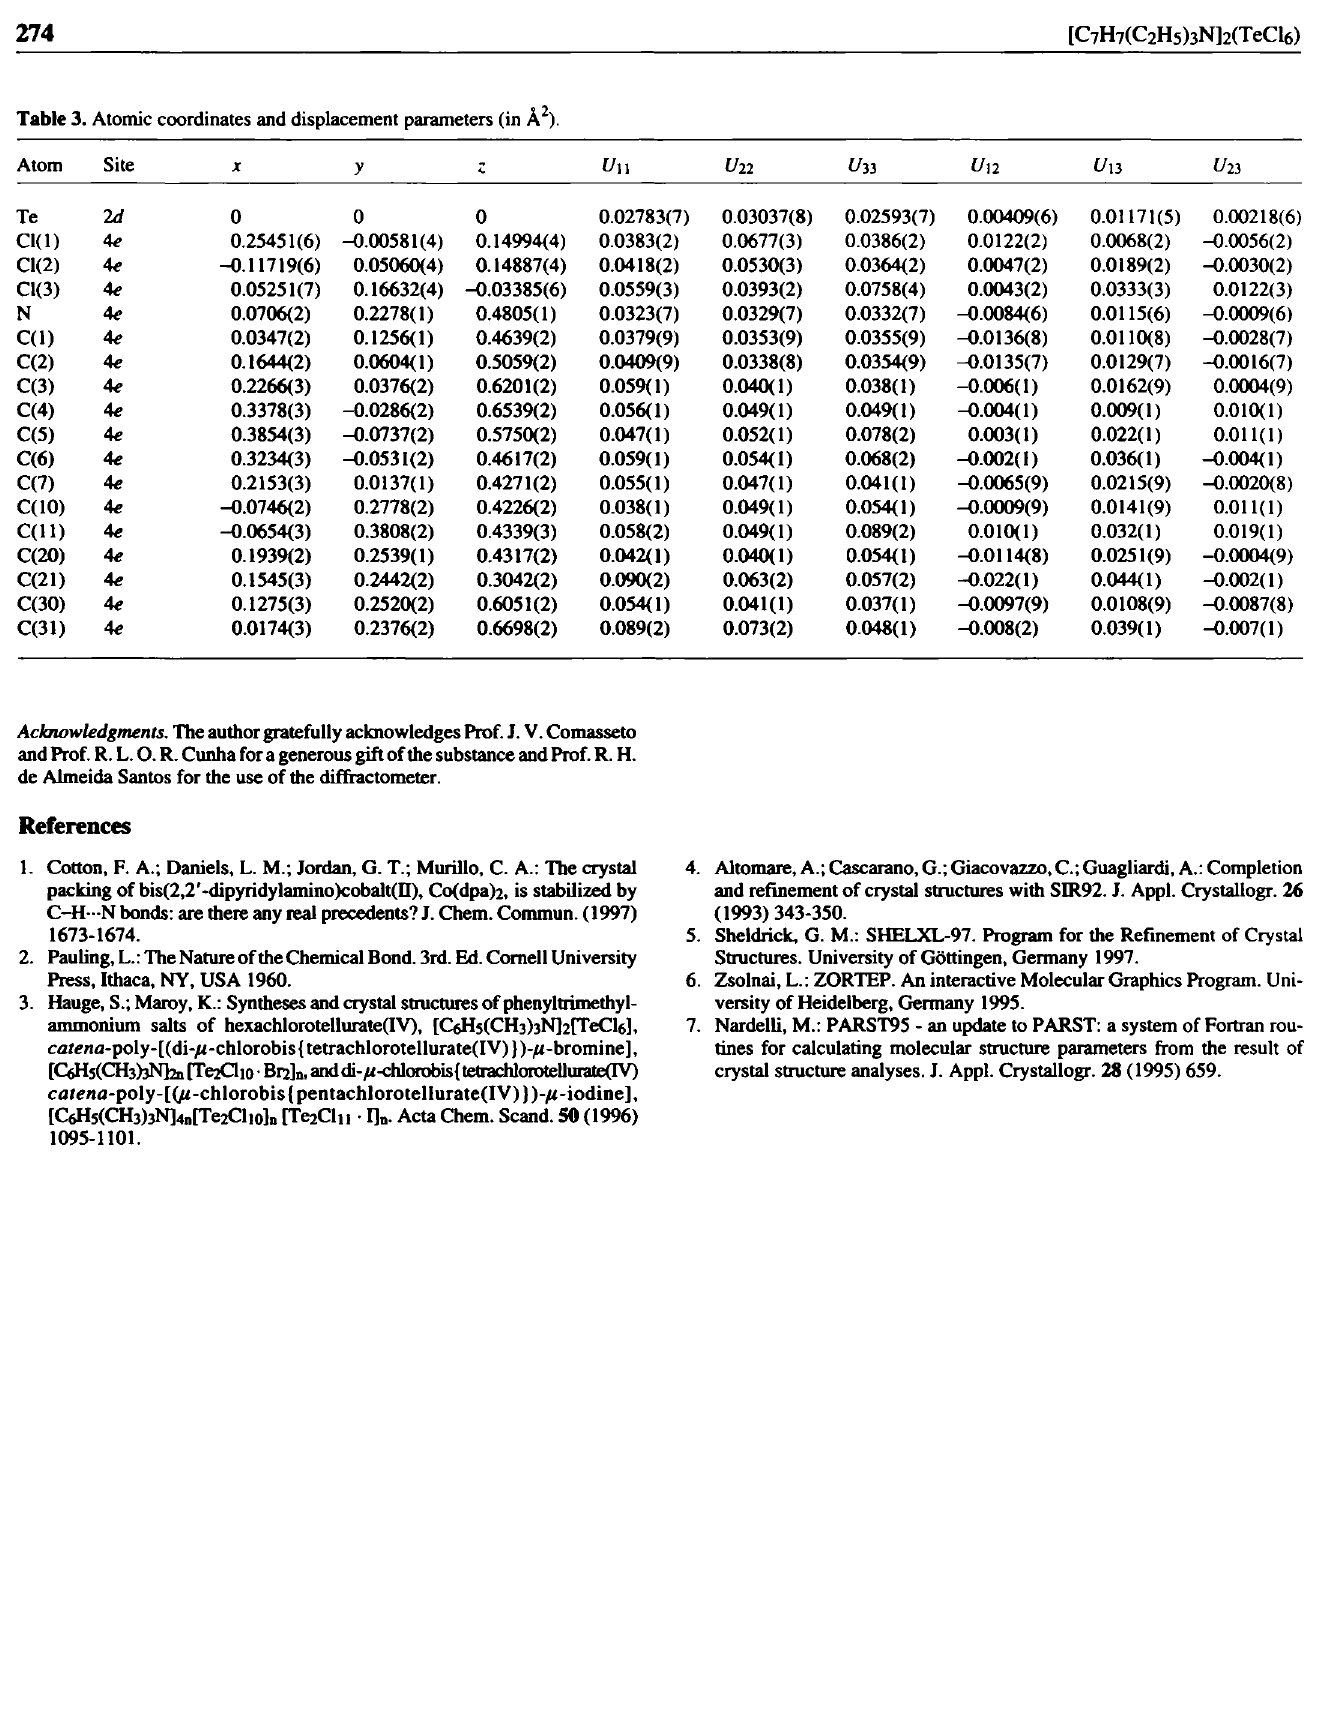
Table 3. Atomic coordinates and displacement parameters (in Â 2